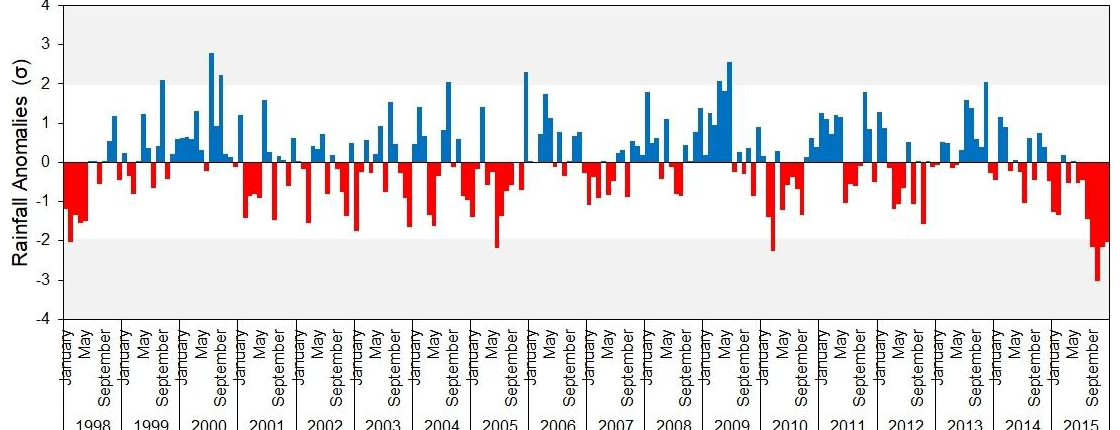
Figure 2. Regional monthly rainfall anomalies. The shaded area represents the significant positive (blue bars) and negative anomalies (red bars). The anomalies were calculated using the monthly average of all the pixels in the Brazilian Legal Amazon.